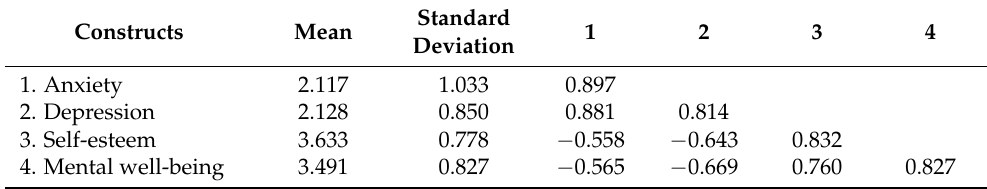
Table 4. Assessing discriminant validity (Fornell–Larcker criterion).